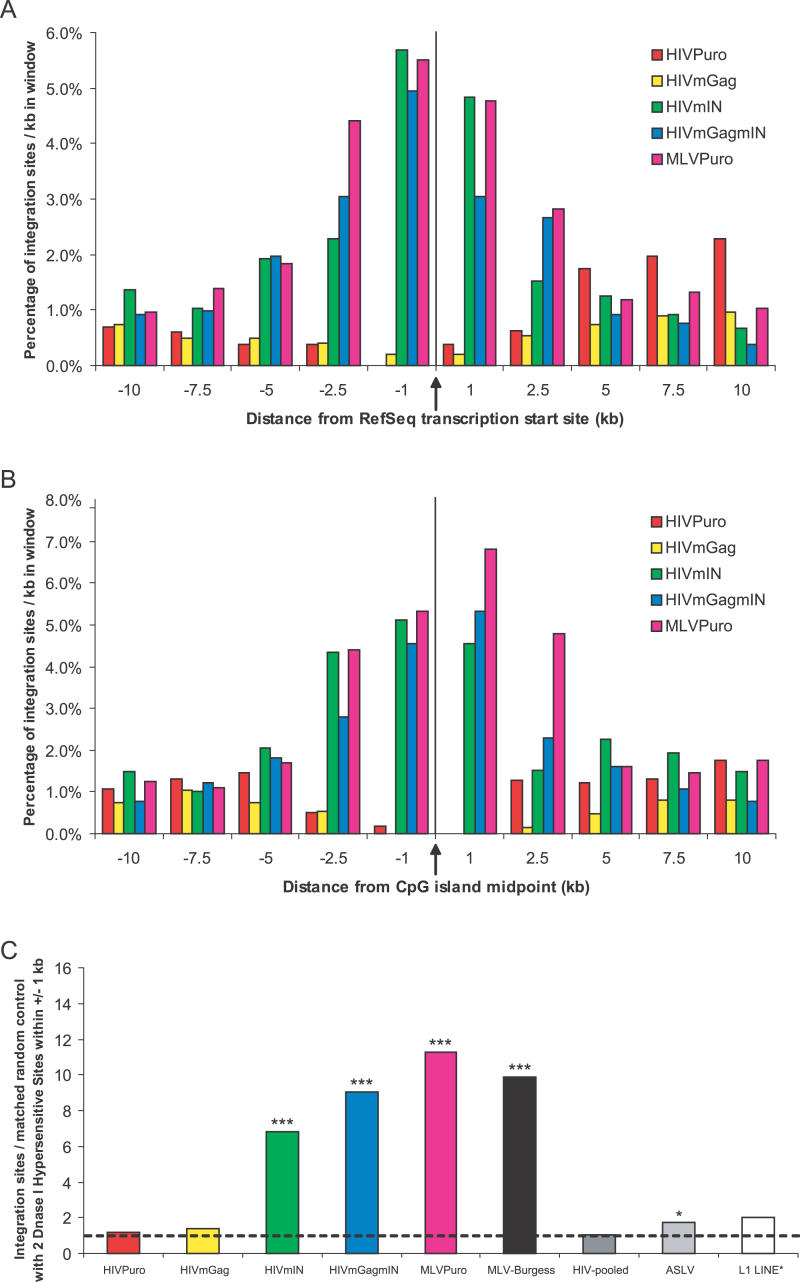
Frequency of Integration near Transcription Start Sites, CpG Islands, and DNase I Cleavage Sites, Illustrating the Contribution of MLV IN to Specificity(A and B) The percentage of integration sites (per kb) within each interval is shown for (A) transcription start sites, and (B) CpG islands.(C) DNase I cleavage sites, For each dataset, the proportion of integration sites found within ± 1 kb of two DNase I cleavage sites was divided by the proportion in the matched random control set. The dotted line represents the expected bar height if the observed data did not differ from the random control set. L1 is displayed as the ratio over an unmatched random set. Three asterisks denote p < 0.0001 by chi-square comparison to random sites. Single asterisk denotes p = 0.0396.